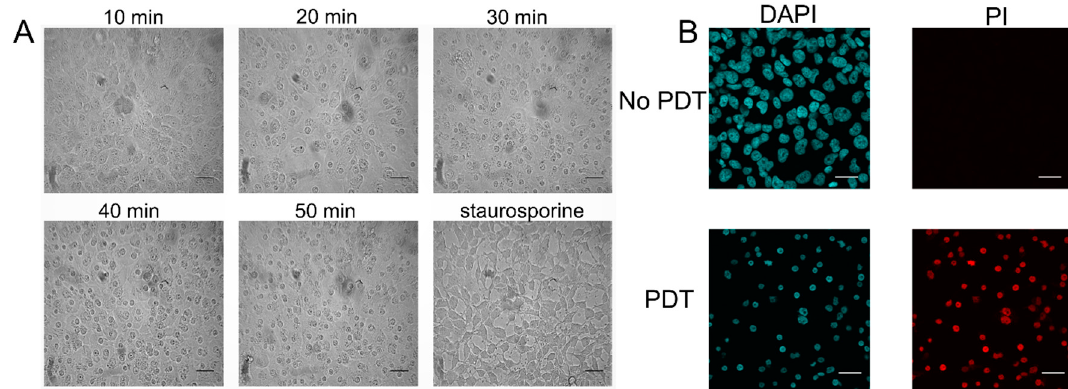
Figure 7. Oncosis responsible for Pd(T4)-PDT oncolytic activity. ( A ) C918 cells post-PDT with 10 µM Pd(T4) and 5 J/cm 2 of 405 nm LEDs at 10, 20, 30, 40, and 50 min, or exposed to staurosporine (5 µM) after 3 h, representing apoptotic cells. Scale bars equal 100 µm. ( B ) Cells were grown to confluency in 8 well chamber slides and left untreated or treated with 10 µM Pd(T4) followed by 5 J/cm 2 of 405 nm light and stained with propidium iodide 15 min post-PDT to determine necrosis involvement. Scale bars equal 30 µm. DAPI: 4 ′ ,6-diamidino-2-phenylindole; PI: propidium iodide